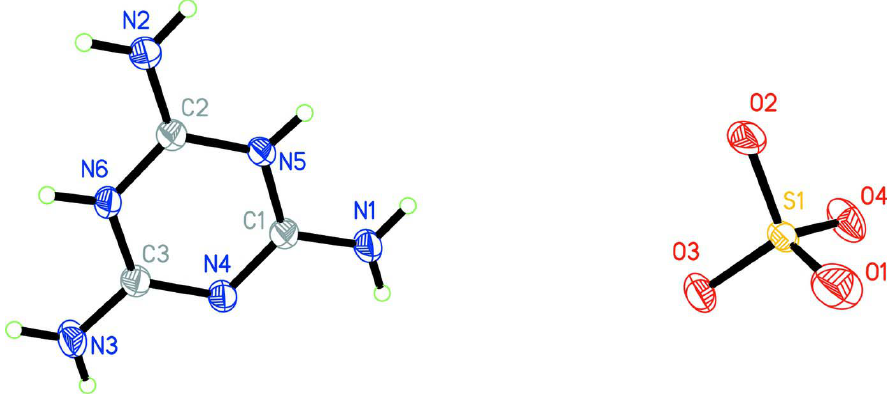
View of the asymmetric unit of (I) showing the atom-labelling scheme. Displacement ellipsoids are drawn at the 50% probability level. H atoms are represented by circles of arbitrary size.